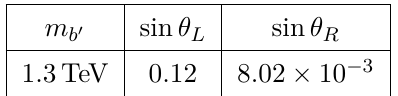
Table 1 . Values of some important parameters of the vectorlike singlet b 0 model considered for the illustration.